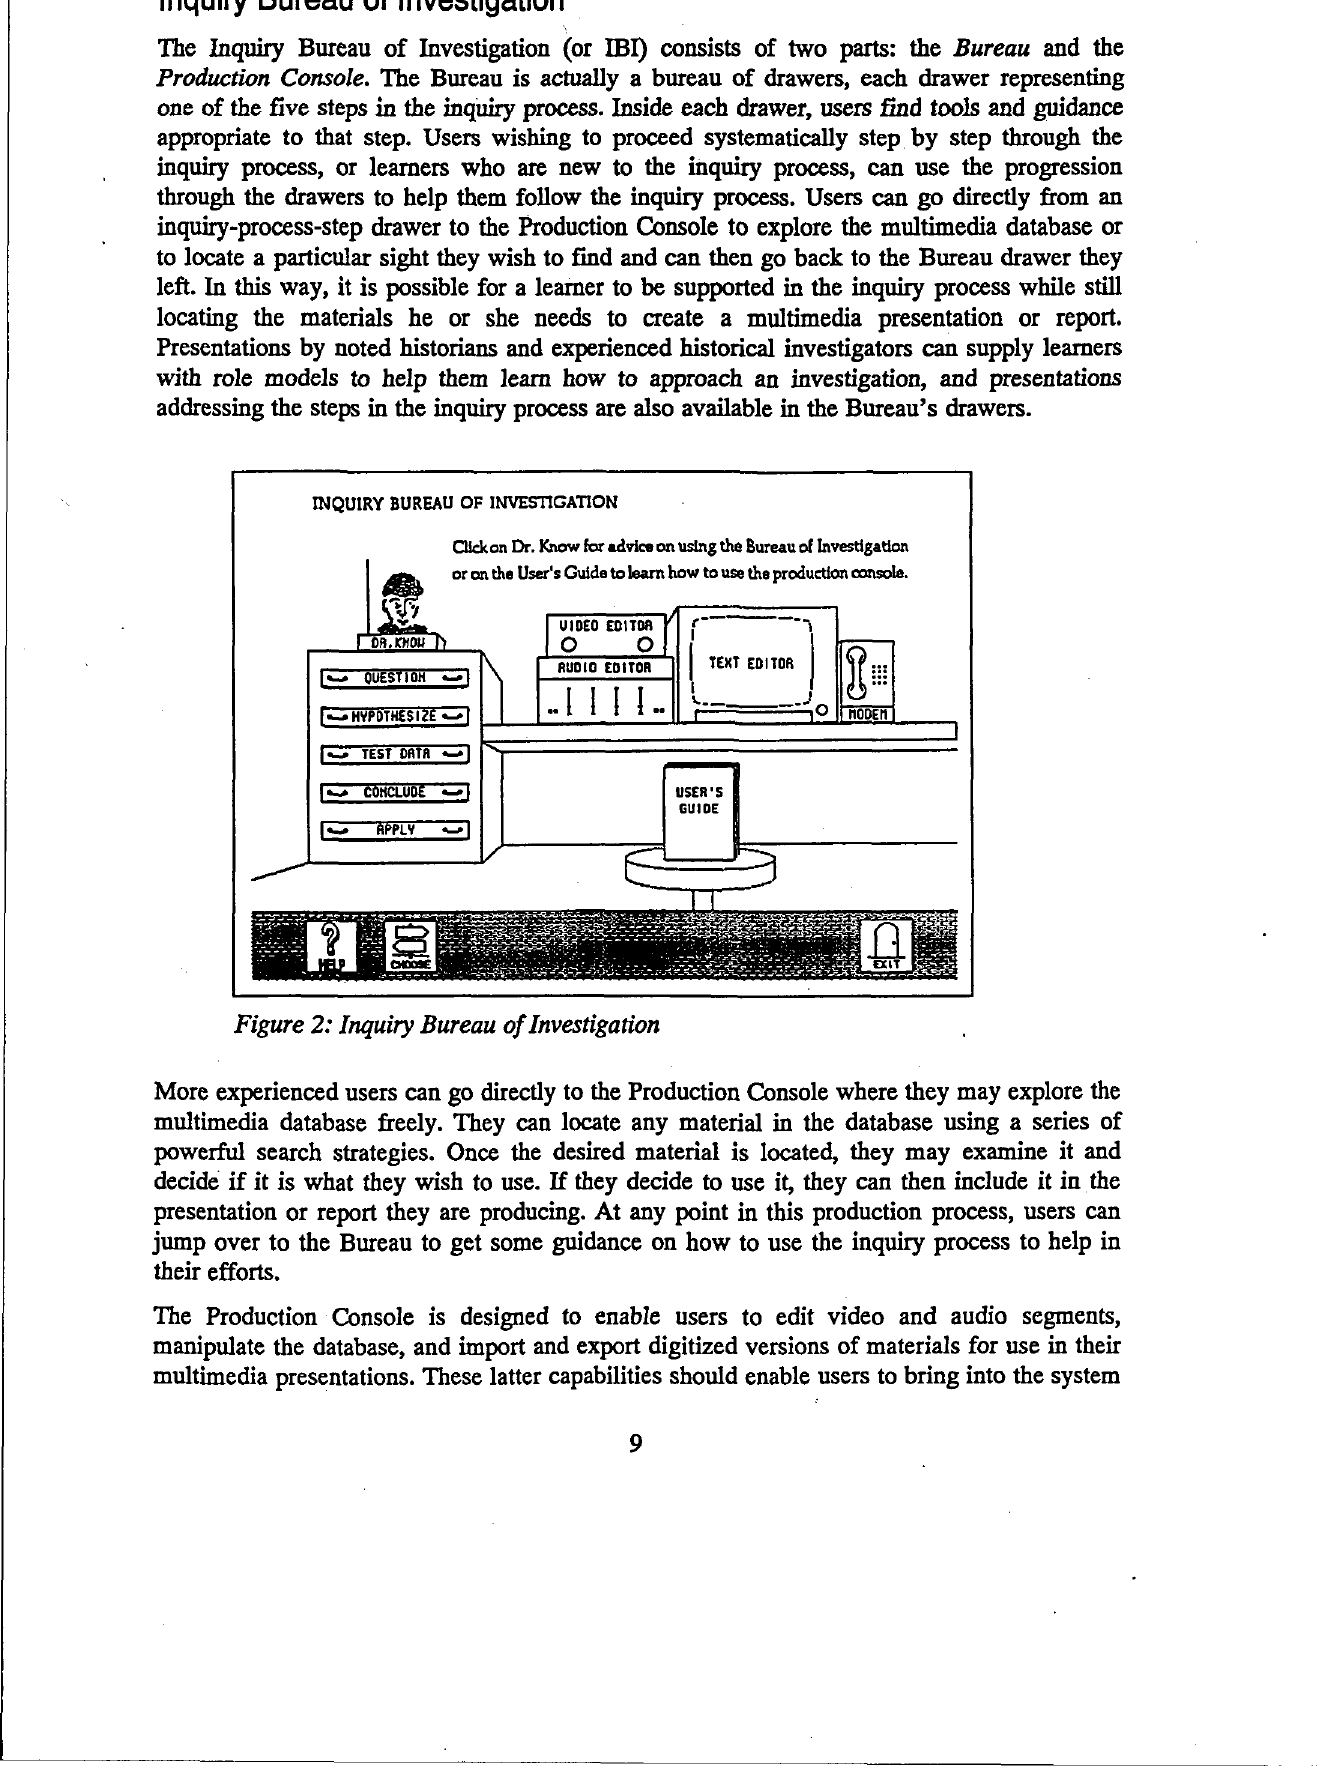
Figure 2: Inquiry Bureau of